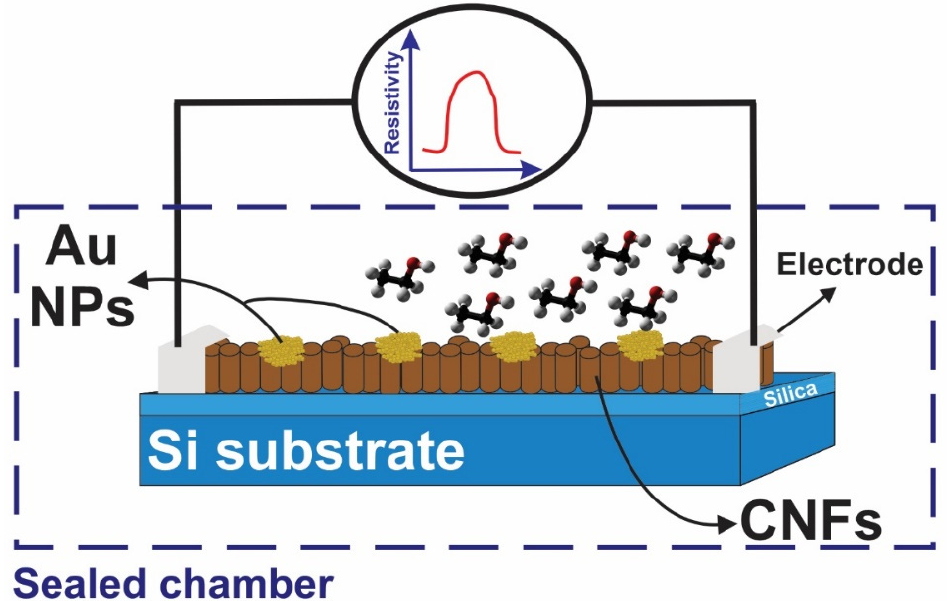
Figure 1. Schematic diagram of the gas testing